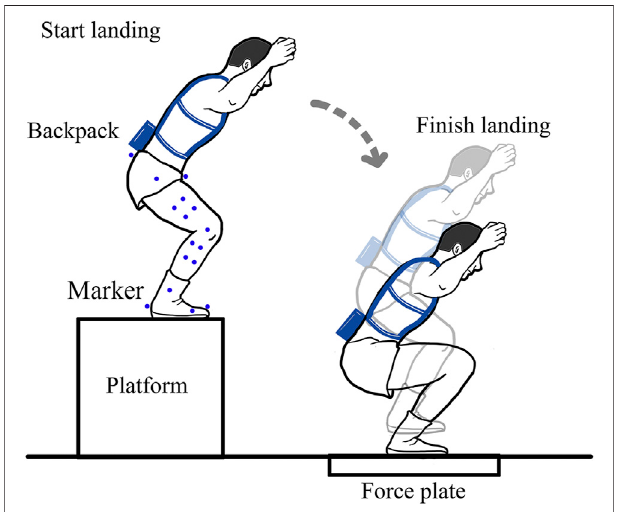
FIGURE 1 | The schedule of the half-squat parachuting landing experiment.